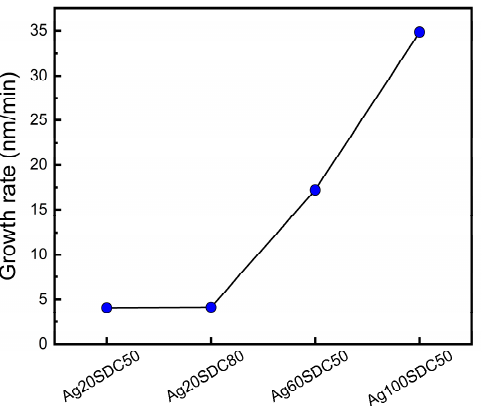
Figure 3. Growth rate of Ag-SDC cermet cathodes with various sputtering power conditions. The nanostructures of Ag-SDC cermet cathodes were investigated with SEM images (Figure 4). We found that the morphology of all the Ag-SDC thin films presented almost identical grain structures except the film deposited with Ag20-SDC50. The Ag20-SDC50 thin film showed a vague morphology with particles on the surface. This nanostructure can be attributed to the relatively lower DC and RF sputtering powers, which may reduce surface adatom mobility and restrain the grain growth in the sputtering process [29,30]. Moreover, it was also reported that this nanostructural tendency can be more remarkable in Ag-ceramic composites because the Ag easily segregates to the grain boundaries and hinders the grain growth during the deposition [31]. The aggregation of Ag particles on the surface of the film was detected as a result of reducing the surface energy of metallic particles during the film growth (Figure 4c), which is in line with previous reports [32,33]. However, more interestingly, the higher RF power condition of Ag20-SDC80 than Ag20- SDC50 showed well-developed grains (Figure 4d). It was assumed that the sufficient sur- face adatom mobility allowed the adatoms to migrate to energetically favorable locations to minimize their surface energy, resulting in grain development. Thus, no Ag aggrega- tion was observed in the Ag20-SDC80 thin film, implying that there were stabilized Ag atoms inside of the film structure. The AFM results showed the same tendency of surface topography for all the Ag-SDC cermet cathodes (Figure 5). The cermet film deposited with the Ag20-SDC50 sputtering condition also showed nanoparticles on the surface, while the other films revealed relatively developed grains in their nanostructures.